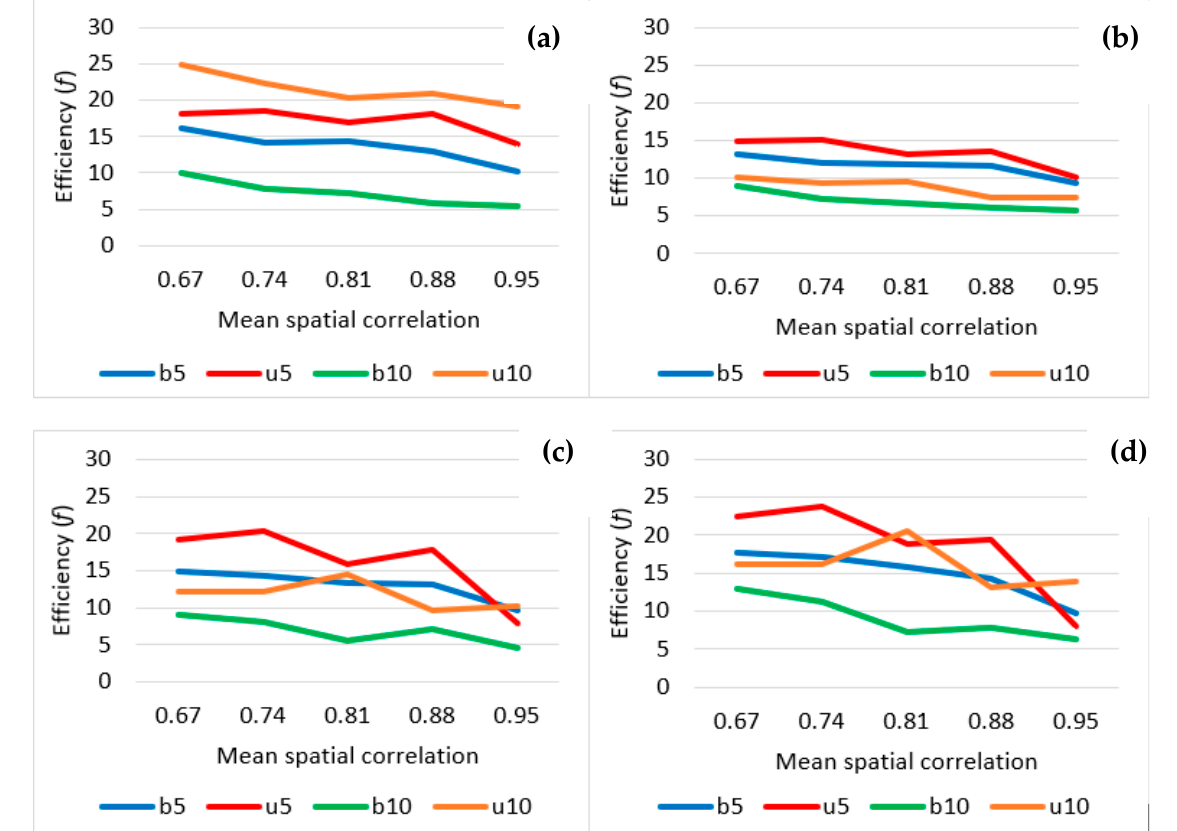
Figure 4. Efficiency of metadata use ( f ) in the function of the mean spatial correlation in networks, in the examples of 4 settings of homogenization: b5—bivariate homogenization of networks of 5 time series; u5—univariate homogenization of networks of 5 time series; b10—bivariate homogenization of networks of 10 time series; and u10—univariate homogenization of networks of 10 time series. Upper left panel ( a ) CRMSEm, upper right panel ( b ) CRMSEy, bottom left panel ( c ) Trend bias for individual time series (Trbias), bottom right panel ( d ) Network mean trend bias (Trnetb).